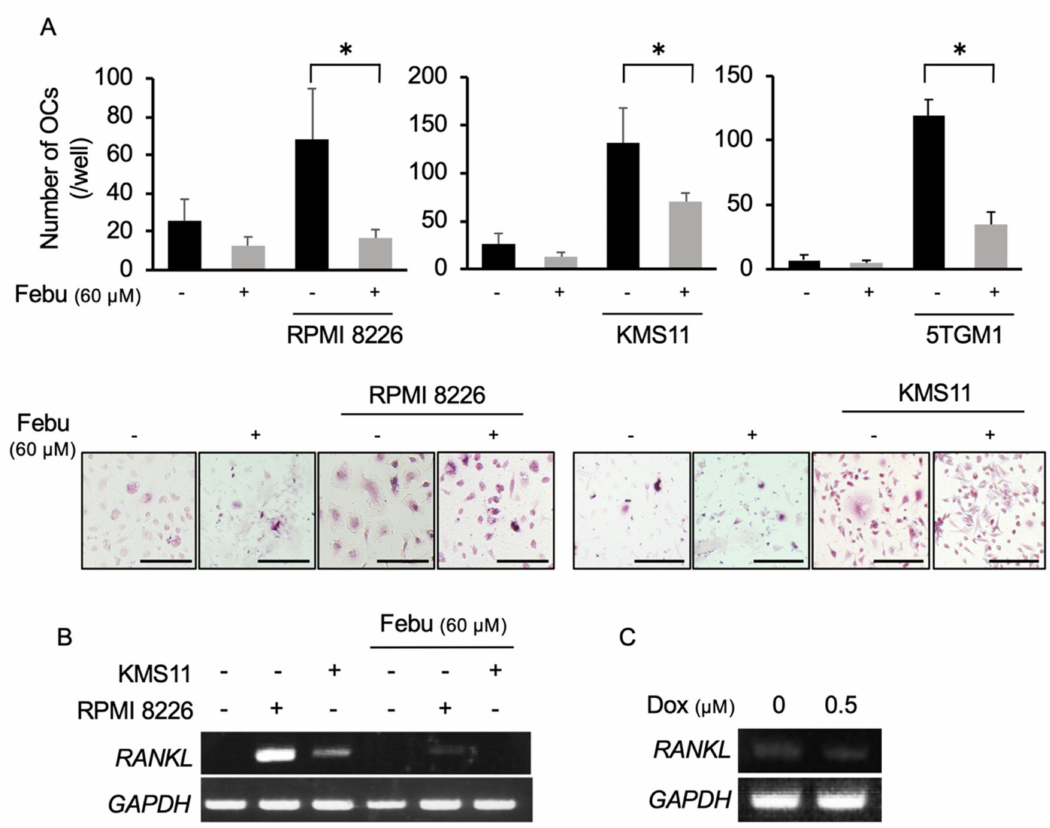
Figure 4. Febuxostat suppresses osteoclastogenesis by MM cells. ( A ) Mouse whole bone marrow cells were seeded onto 24-well plates and cultured with M-CSF (10 ng / mL) for 3 days. After that, human MM cell lines (RPMI8226 and KMS-11) and the murine MM cell line 5TGM1 were added onto the cells. The cells were cultured in quadruplicate with or without febuxostat (Febu) (60 µ M) for 14 days in the presence of M-CSF (10 ng / mL). The numbers of TRAP-positive multinucleated cells per well were counted. Data are expressed as mean ± SD. * p < 0.05. Representative photos are shown. Original magnification, × 200. Bar, 100 µ m. ( B ) Human bone marrow stromal cells were cultured with RPMI 8226 and KMS-11 MM cell lines in the presence or absence of Febu at 60 µ M for 24 h. After removing the MM cells, the expression of RANKL in the bone marrow stromal cells was detected by RT-PCR. GAPDH served as an internal control. ( C ) Human bone marrow stromal cells were cultured with Dox at 0.5 µ M for 24 h. The expression of RANKL mRNA was detected by RT-PCR. GAPDH served as an internal